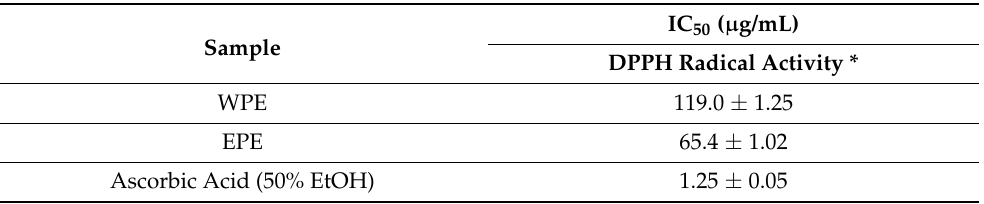
Table 5. In vitro DPPH radical scavenging: IC50 values were calculated for water and ethanol leaf extracts to scavenge DPPH free radicals. * ( n = 3).